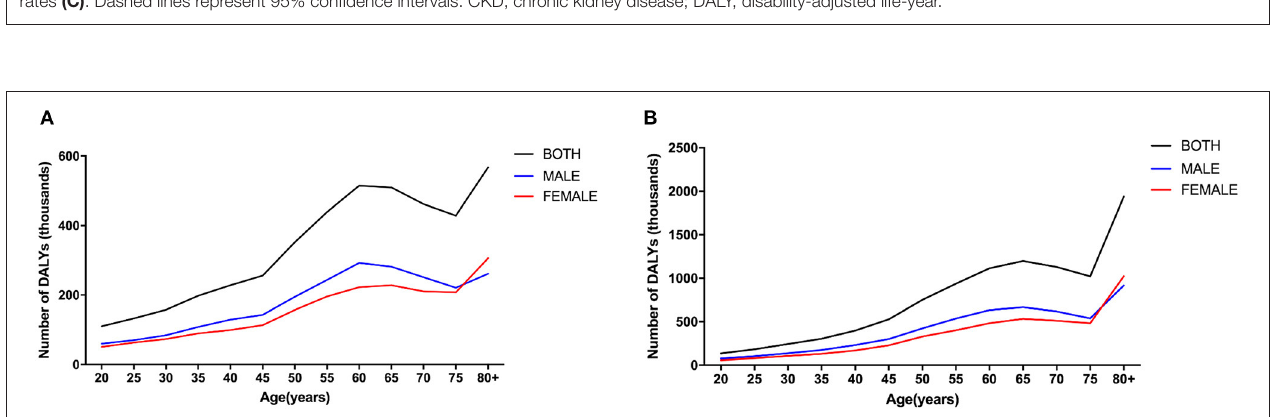
FIGURE 2 | Age- and gender-specific global disease burden of CKD due to hypertension. DALY numbers in 1990 (A) , and DALY numbers in 2019 (B) . CKD, chronic kidney disease; DALY, disability-adjusted life-year.